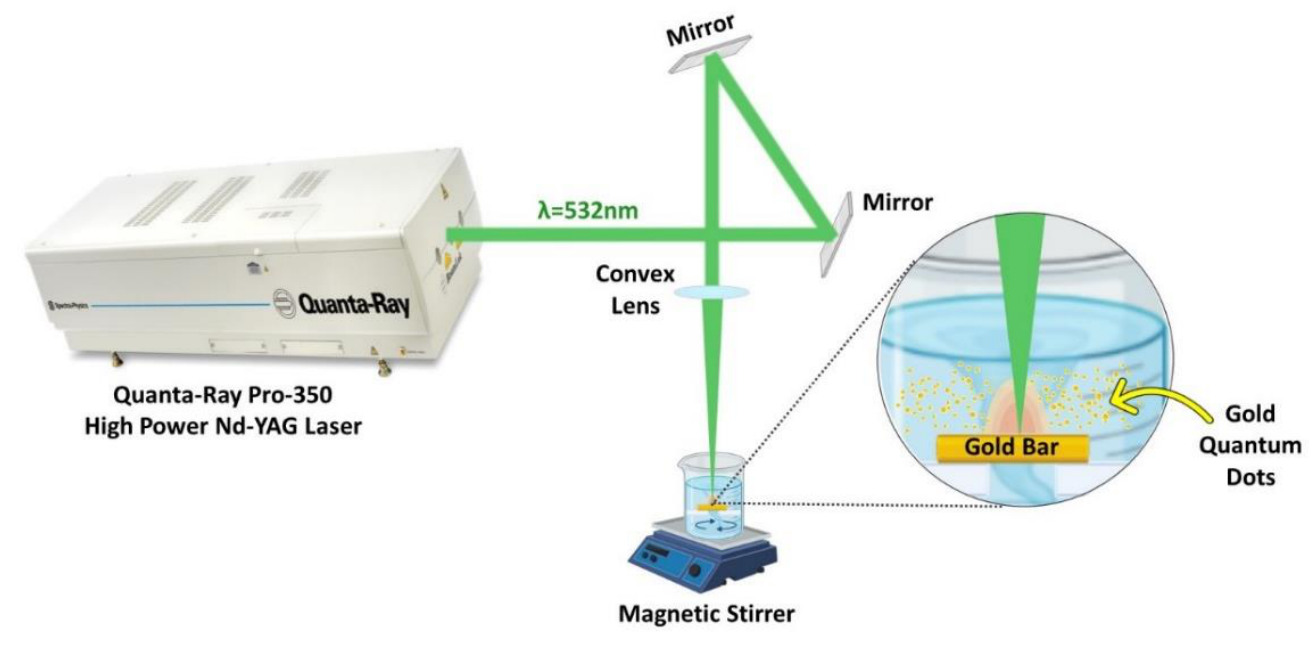
Figure 1. Schematic diagram of the laser ablation in liquid; experimental setup for the synthesis of AuQDs using the 2nd harmonic of the Nd: YAG 532 nm pulsed laser.